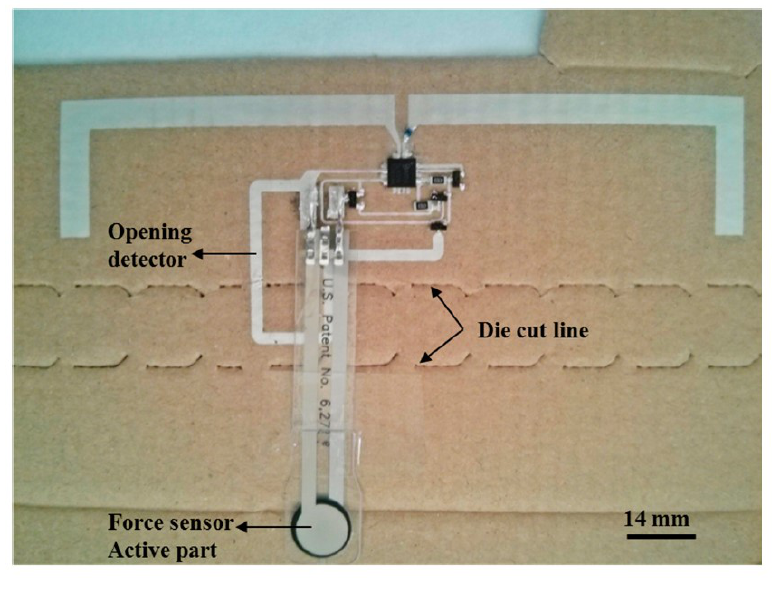
Figure 26. Implemented circuit of the force sensor [42].